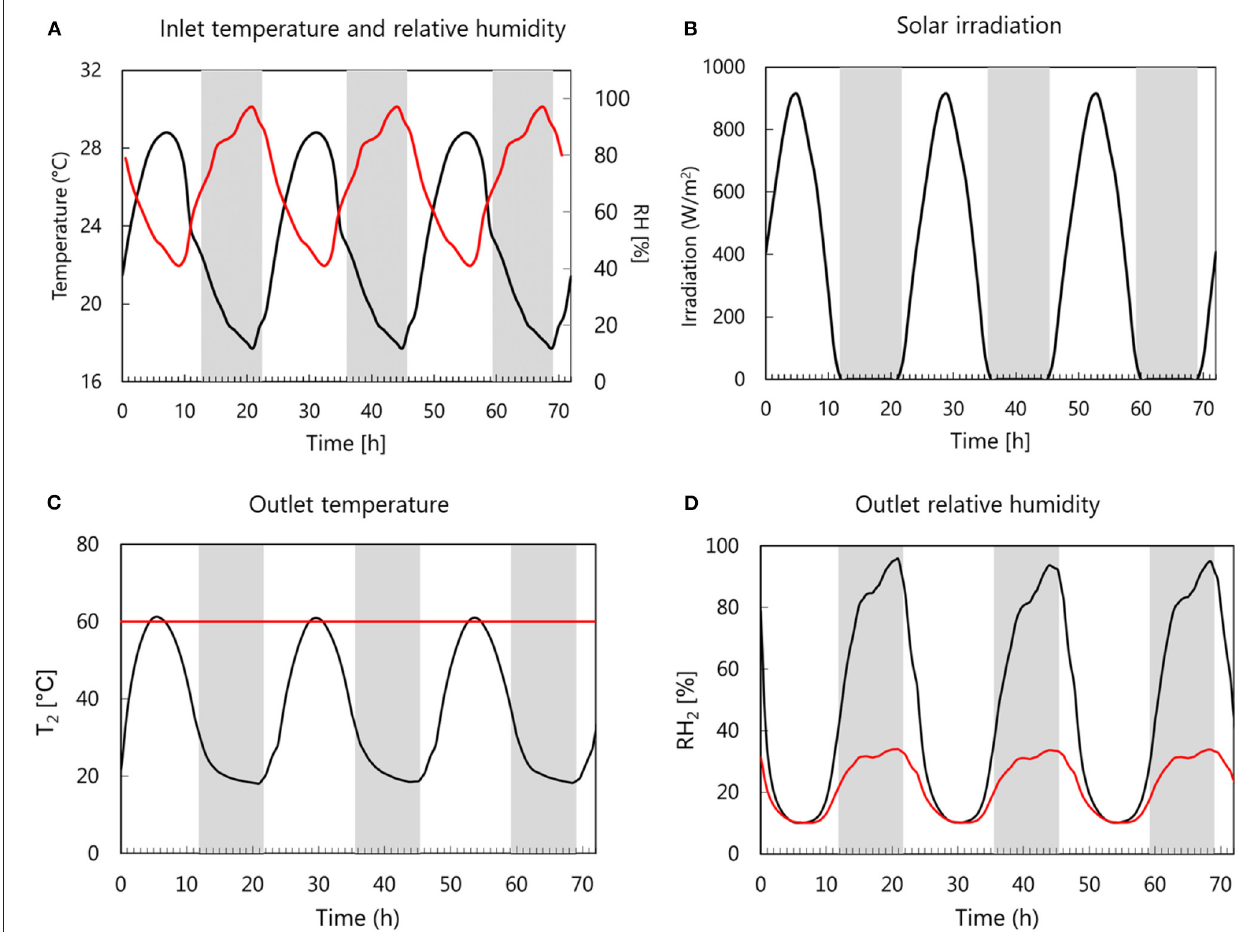
FIGURE 4 | (A) Inlet temperature (black line) and relative humidity (red line) and (B) solar irradiation obtained from the weather data. (C) Temperature and (D) relative humidity of the drying air at the outlet of the solar collector (black lines) compared to the temperature and relative humidity (red lines) for the modeling of constant hot-air temperature